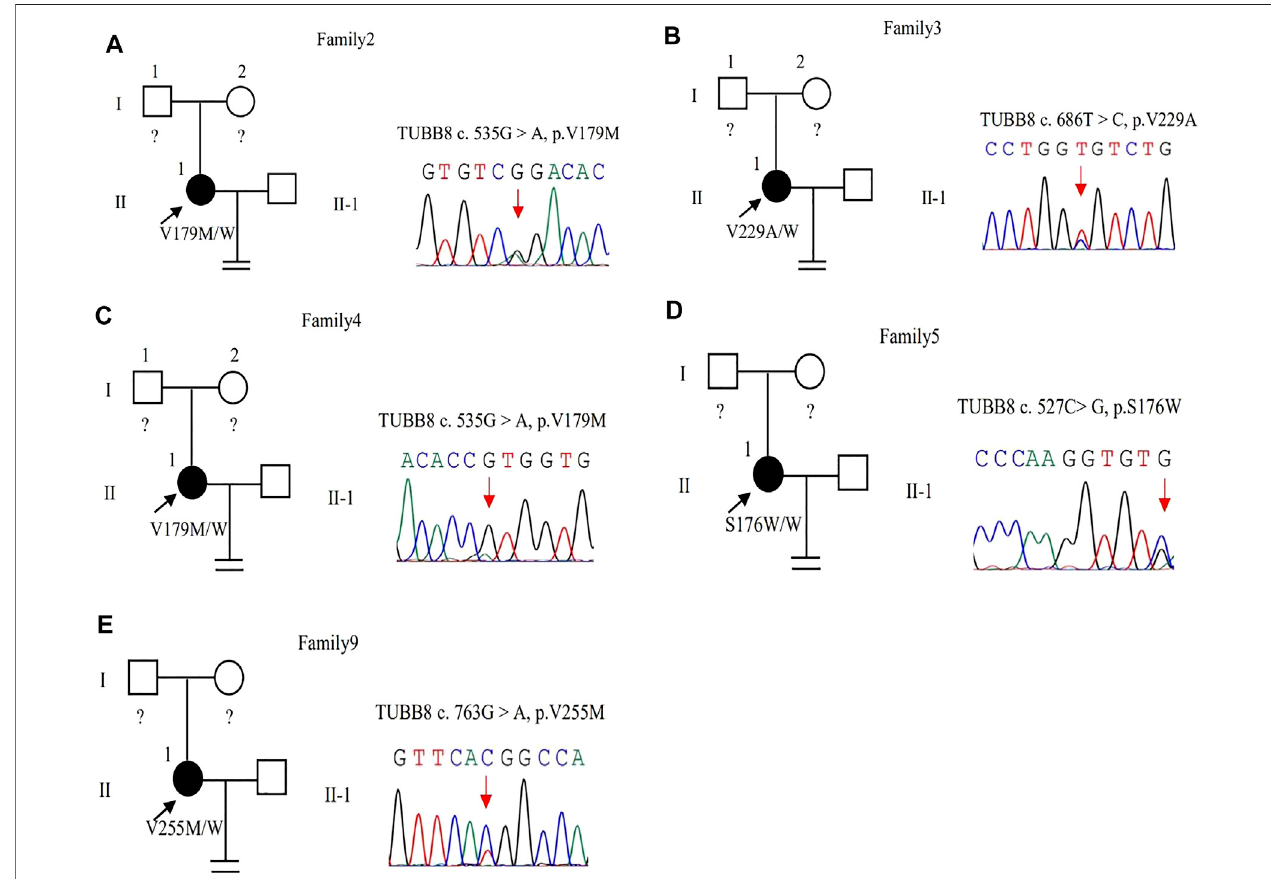
FIGURE 3 | Pedigrees of 5 families with TUBB8 variants. Sanger sequencing con fi rmation is shown on the right of the pedigrees. The “ = ” sign indicates infertility, and black circles represent affected individuals. The “ W ” sign means wild type, and question marks indicate the absence of a DNA sample. (A – E) represent different